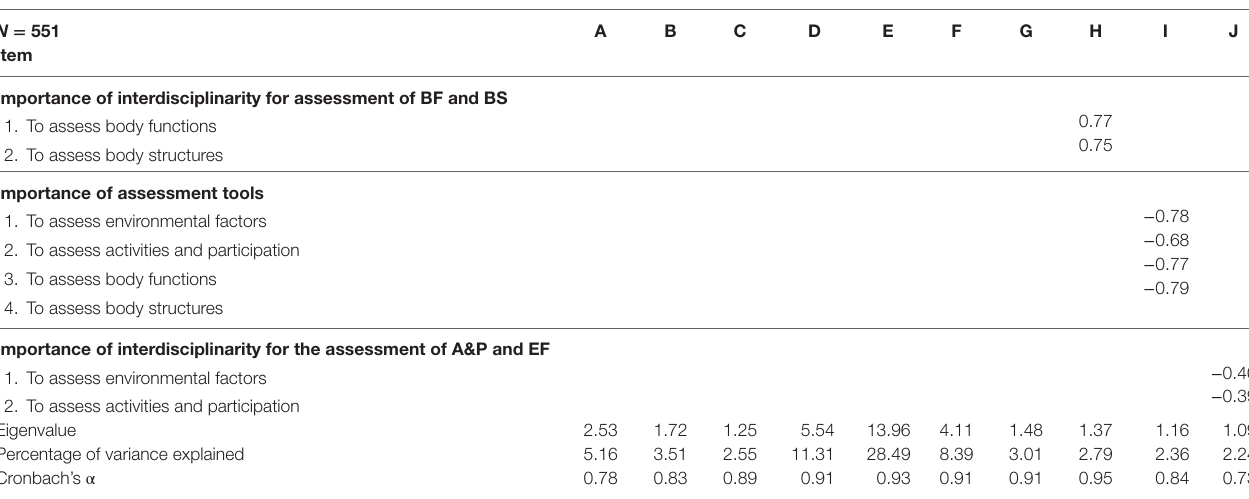
Table 4 | Mean and SD of variables considered in this study.